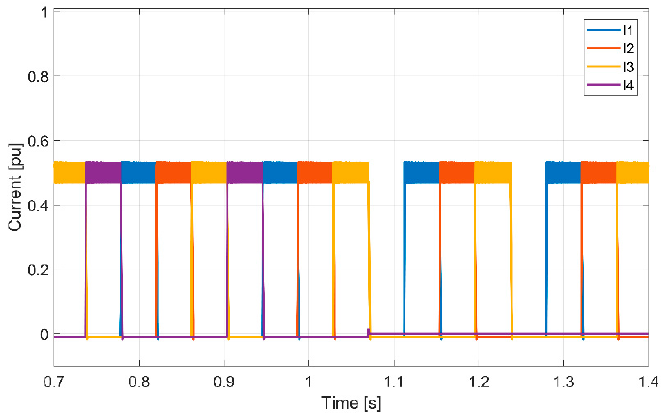
Figure 6. Motor winding currents of the switched reluctance motor ( SRM) at 60 rpm in normal condition and open-circuit failure of power device S 1 D (simulation result).